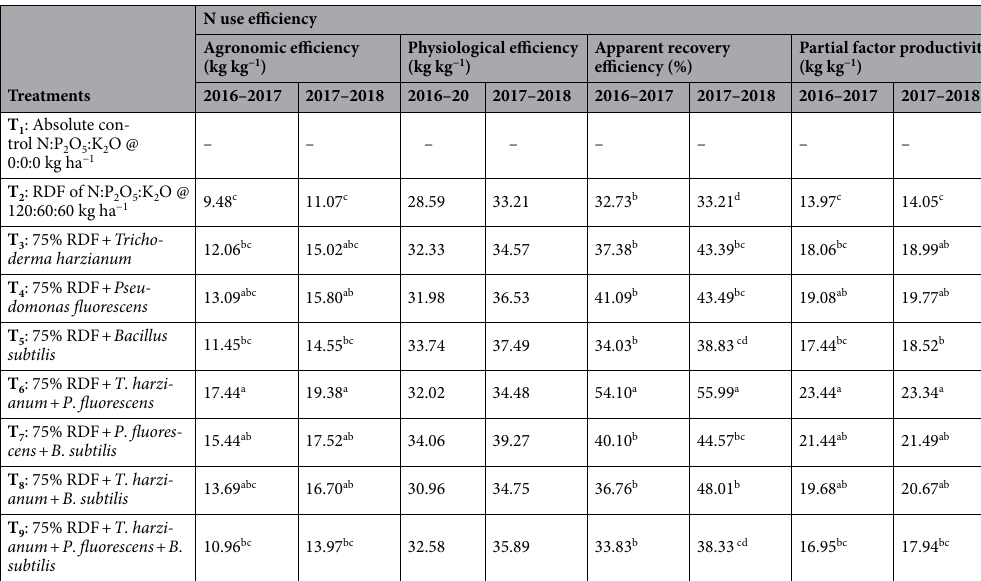
Table 1. Nitrogen use efficiency of red cabbage as influenced by bio-priming and fertilisation. Different letters indicate significant differences at P ≤ 0.05 among the treatments as per DMRT.